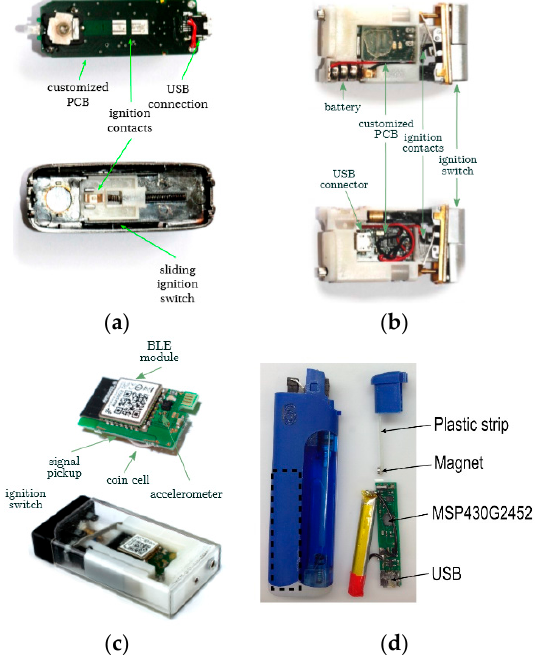
Figure 3. The instrumented lighters: ( a ) UbiLighter v1; ( b ) UbiLighter v2; ( c ) UbiLighter v3; ( d ) the Personal Automatic Cigarette Tracker (PACT) lighter (image source: [60,61]).